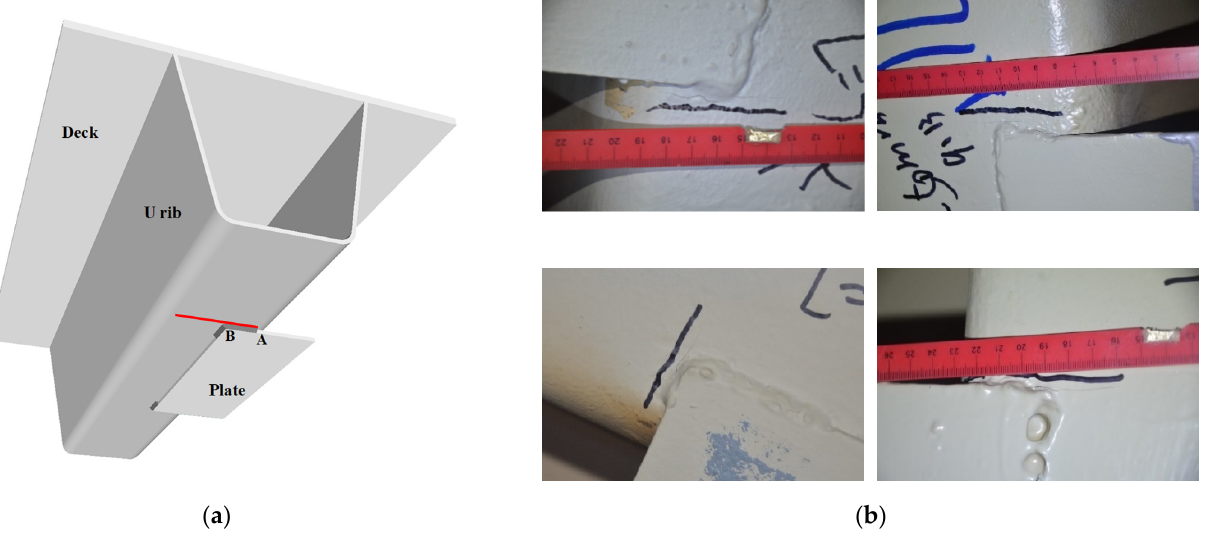
Figure 15. Actual bridge inspections for fatigue cracks at welding joints. ( a ) Illustrations of welding joint and fatigue crack location. ( b ) Representative fatigue cracks at local welding joints.